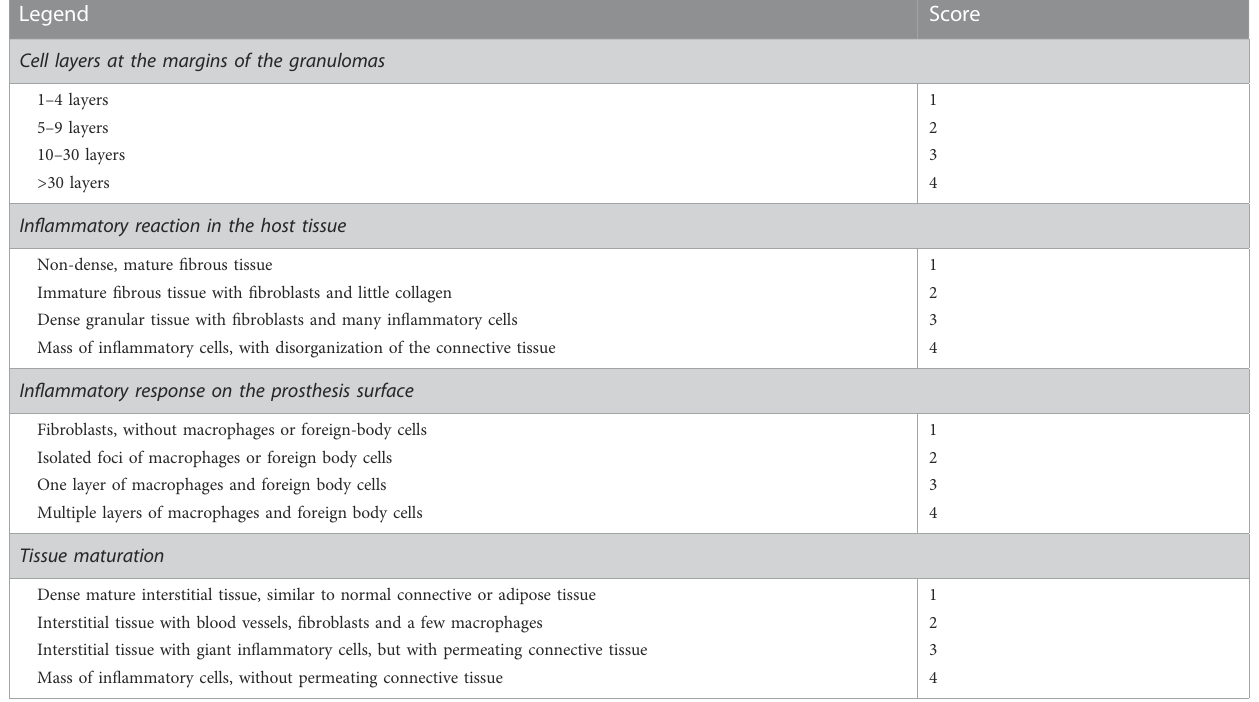
TABLE 2 The Harrell Scoring scale. Legend Score